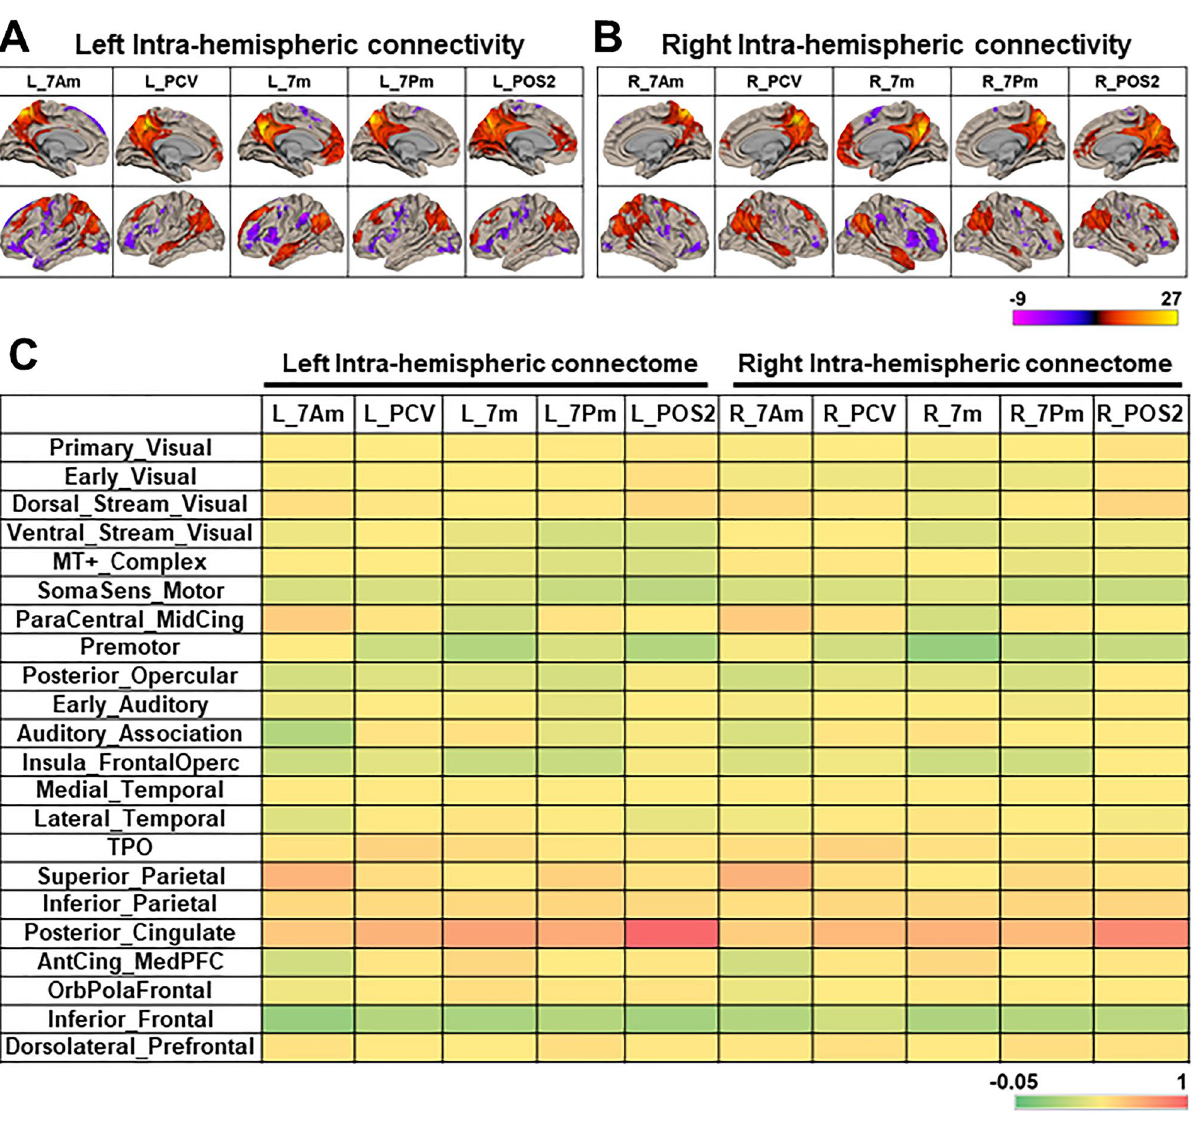
plotting the SC (log streamline count per area) and RSFC (Fisher’s z transformed pairwise ROI correlation) in the left (L) and right (R) hemisphere, respectively. Examining all pairwise connections in the whole-brain, we found there is a SC-RSFC relationship (Spearman’s correlation coefficient = 0.282–0.363[mean; 0.322 ± 0.019] at subject level, all p < 0.05 corrected) (Suppl. Fig. S6). Next, the SC-RSFC correlation coefficient was calculated between each precuneus ROI and whole-hemisphere at group level (Spearman’s correlation coefficient, L_7Am, 0.289; L_PCV, 0.365; L_7Pm, 0.323; L_7m, 0.408; L_POS2, 0.428; R_7Am, 0.385; R_PCV, 0.424; R_7Pm, 0.368; R_7m, 0.368; R_POS2, 0.405, all p < 0.05 corrected) (Fig. 5B, Suppl. Fig. S7). Finally, we here showed schematic diagrams to summarize the structural connection profile by probabilistic tractography, in which the connection patterns of streamlines were described, respectively (Fig. 5C).